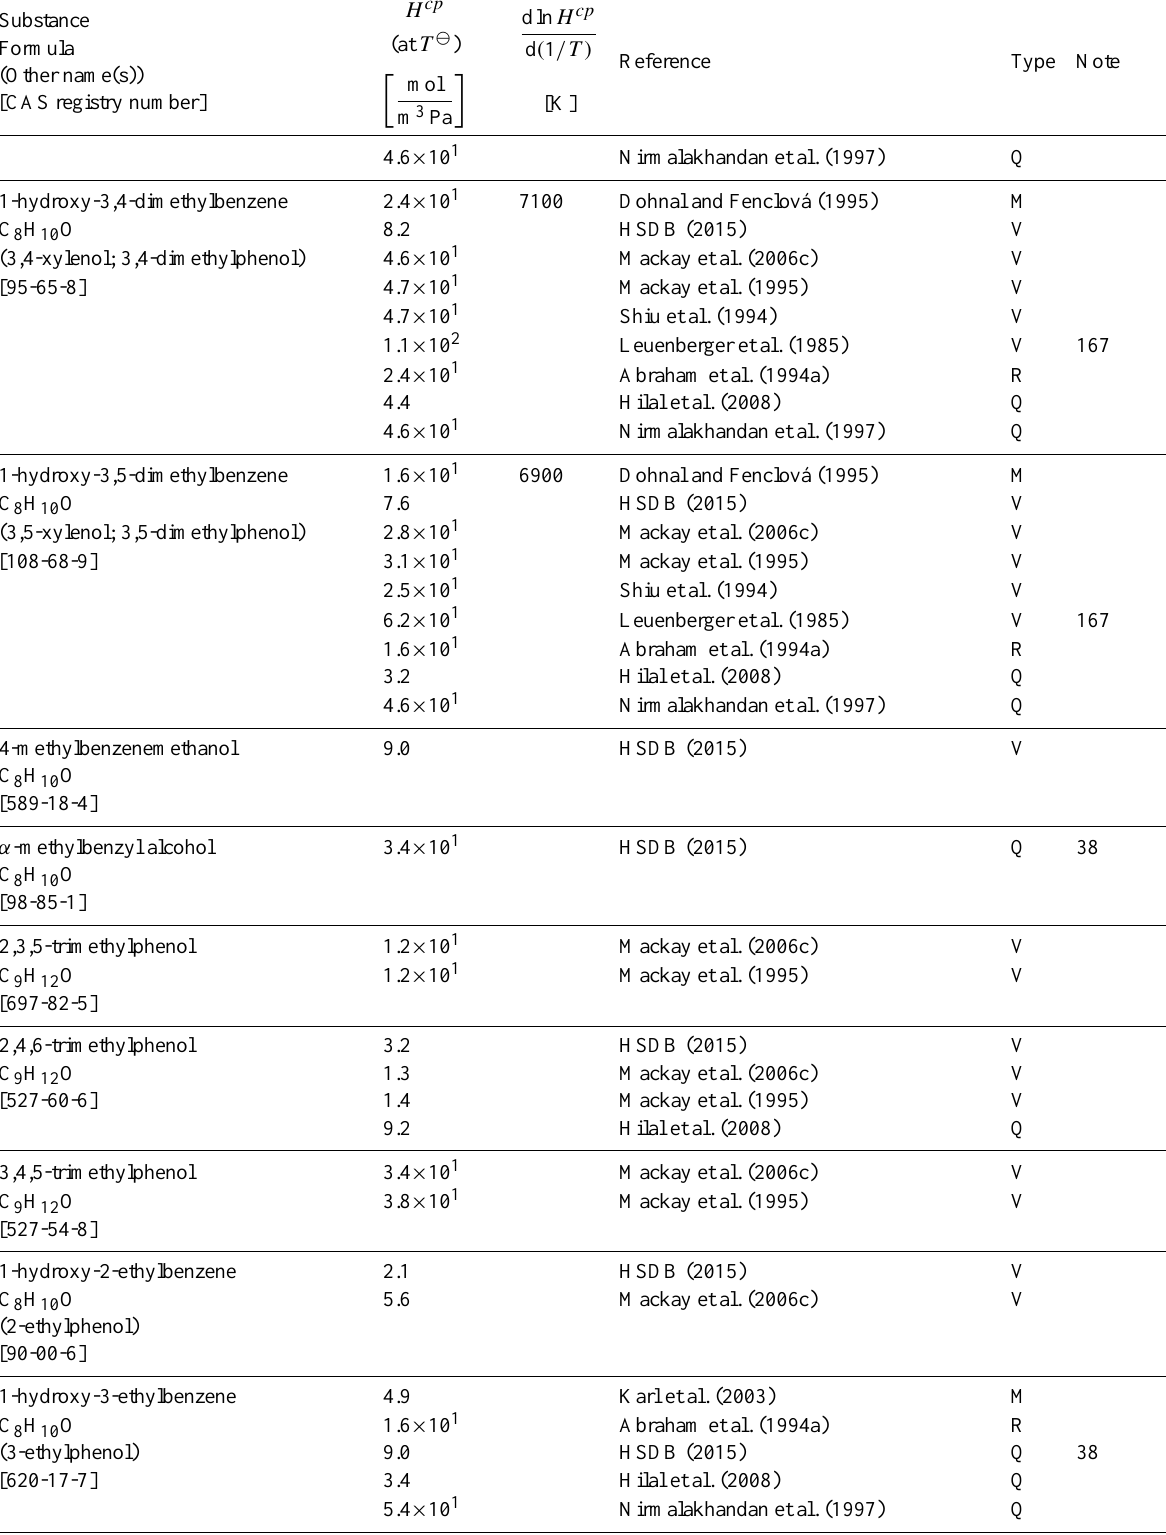
Table 6: Henry’s law constants for water as solvent